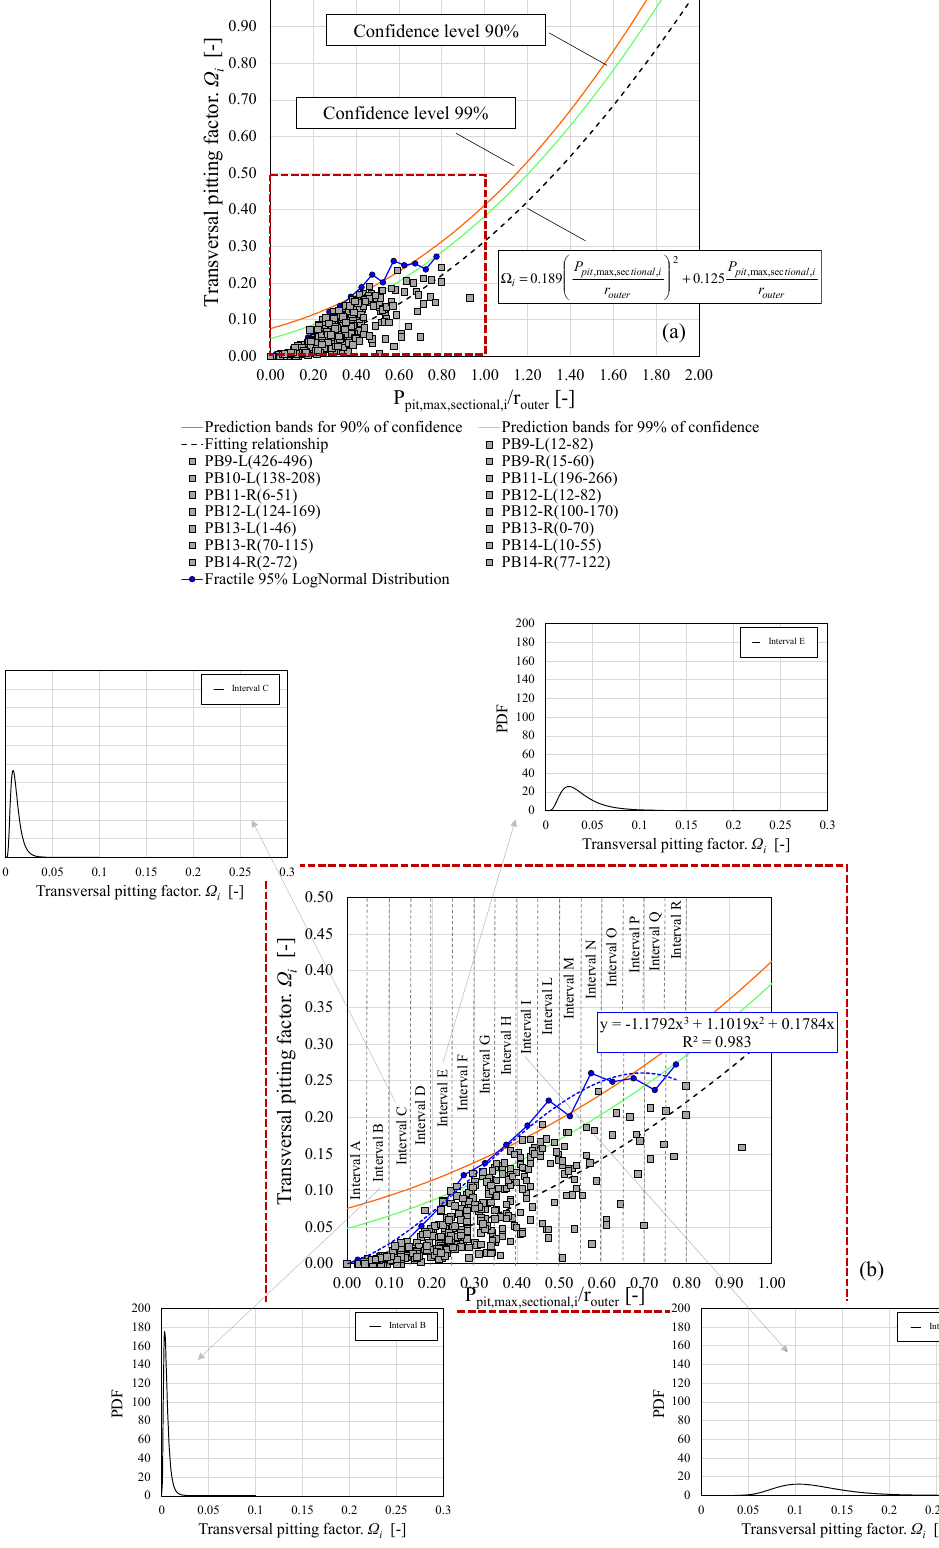
Figure 8. Transversal pitting factor Ω i vs. maximum sectional penetration depth, P pit,max,sectional,i : ( a ) general expression and ( b ) variance of lognormal PDF for each interval of P pit,max,sectional,i